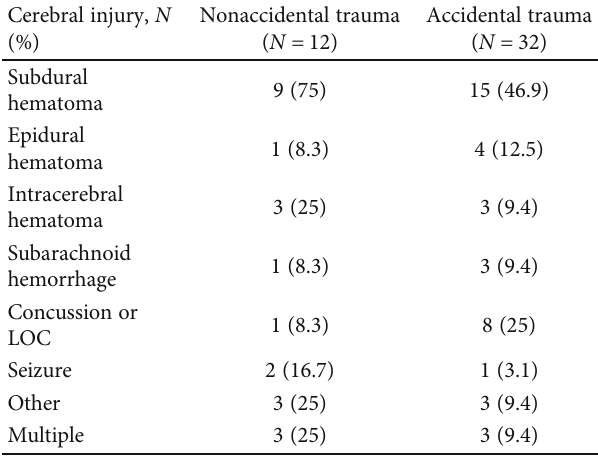
Table 5: Comparison of cerebral injuries seen in cases of NAT and